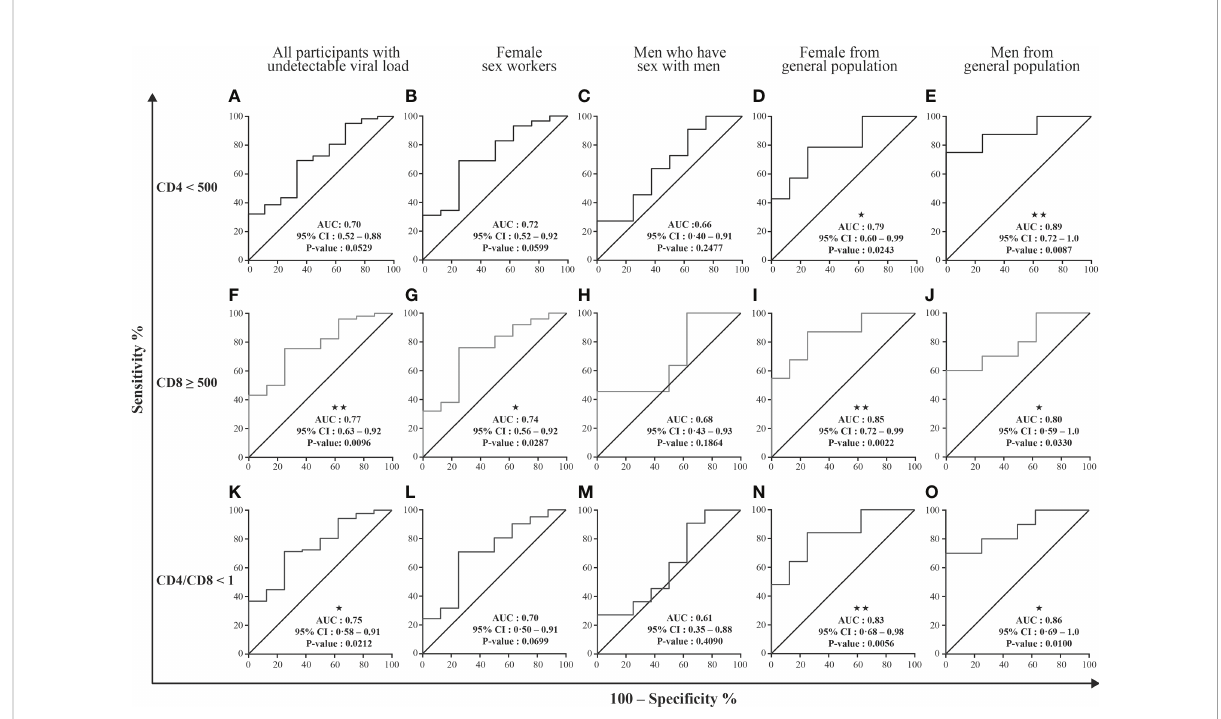
FIGURE 4 EVs miRNAs content diagnosis performance in receiver operating characteristics curves analysis. Large and small EVs miRNA content was used to generate a Receiver Operator Characteristic (ROC) curve analysis to discriminate participants with different conditions. The participants with CD8 T cell < 500 cells/µL, CD4 T cell ≥ 500 cells/µL, and ratio CD4/CD8 ≥ 1 (group 1, n=10) were used as controls. Diagnosis performance of large EVs miR-155 copies for the discrimination of all participants (A, F, K) , female sex workers (B, G, L) , men who have sex with men (C, H, M) , and female (D, I, N) and men (E, J, O) from general population with respectively CD4 T cell count ≤ 500 cells/µL, ratio CD4/CD8 < 1, CD8 T cell count ≥ 500 cells/µL. Wilson/Brown method was used to compute the area under a ROC